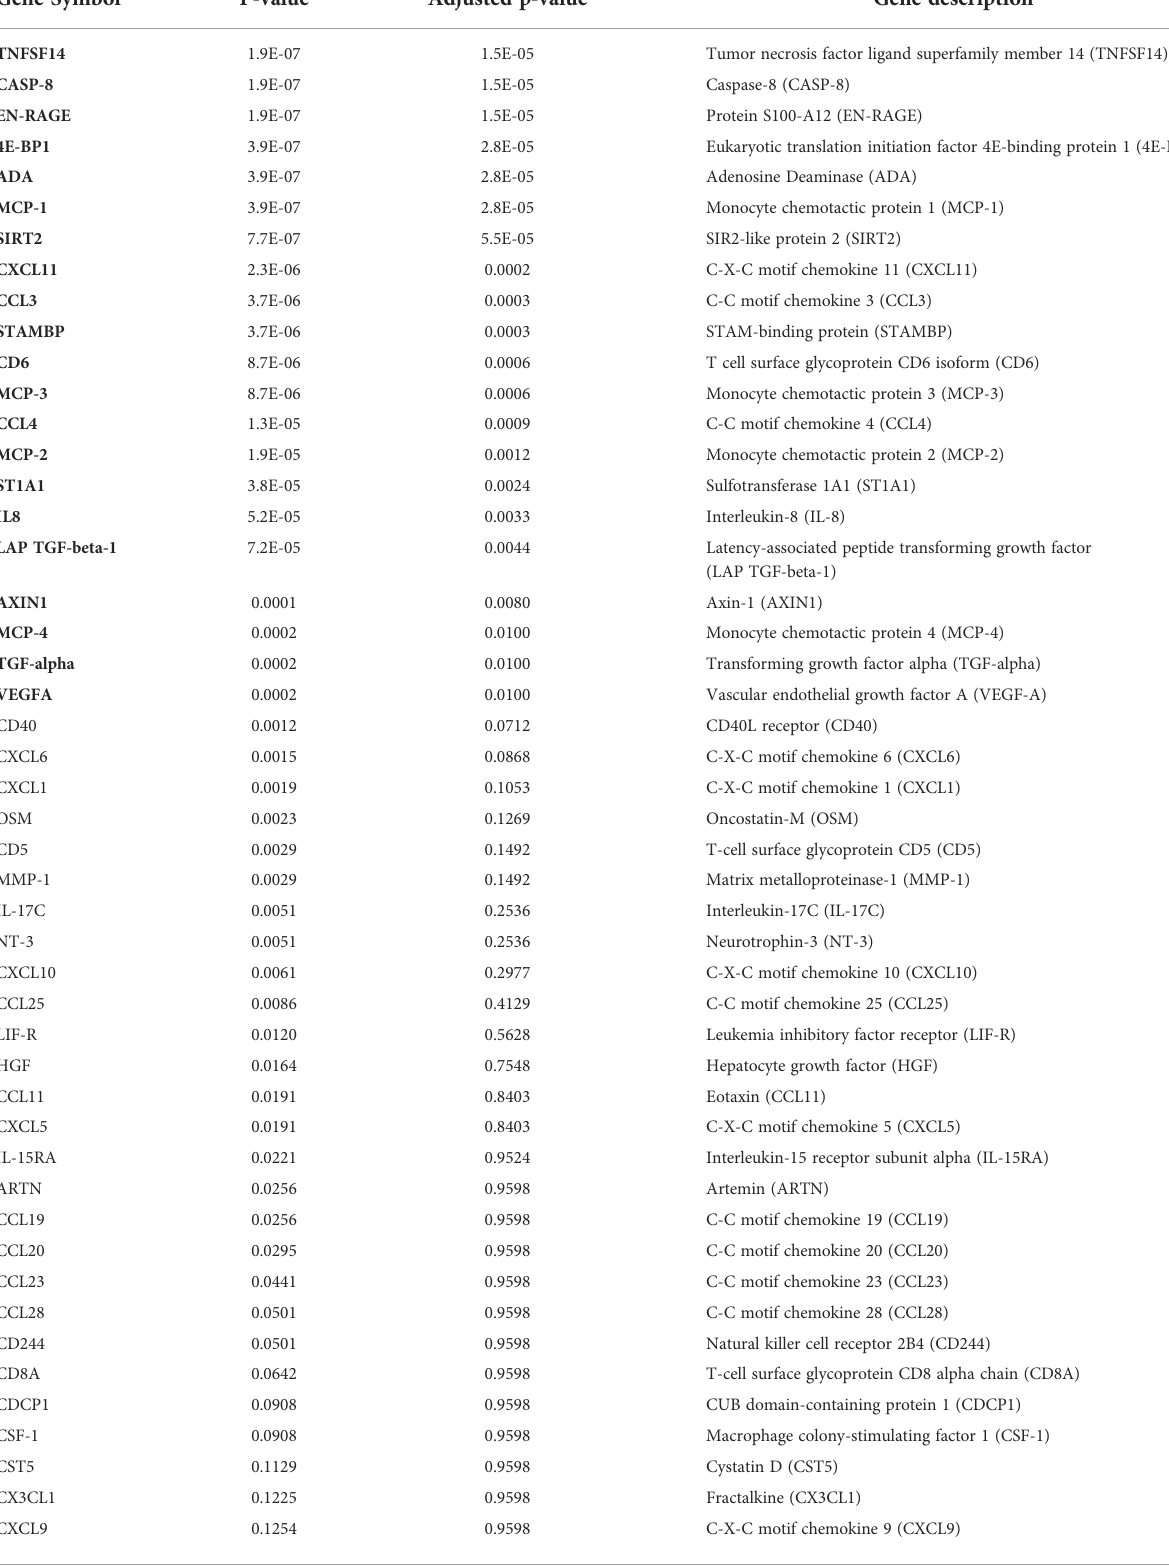
TABLE 3 Detectable in fl ammatory markers measured by proteomic approach and signi fi cance